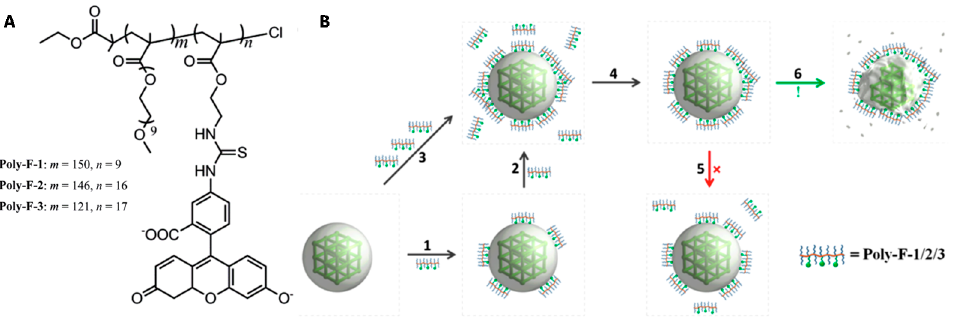
Figure 4. ( A ) Structure of pOEGMA / pAEMA copolymer − fluorescein conjugates (the segment of free AEMA units was omitted for clarification). ( B ) Diagram illustrating the binding / assembly of polymers onto the surface of MIL-101-NH 2 (Fe): (1–3) di ff erent concentrations of polymers incubated; (4) free polymers removed by centrifugation; (5) dissociation of polymer from the surface (not observed); (6) degradation of MIL-101-NH 2 (Fe) and redistribution of surface polymers [62].